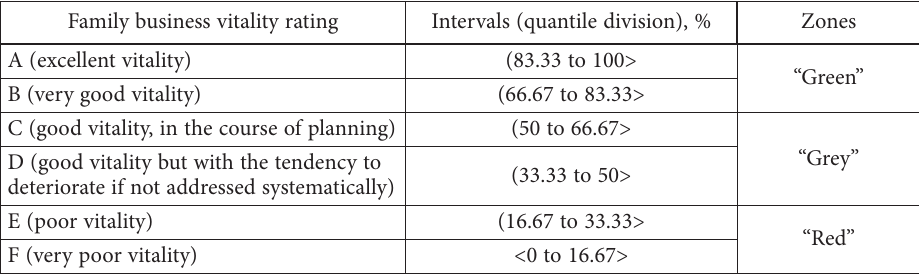
Table 2. Family business vitality rating grades (source: authors’ creation) Family business vitality rating